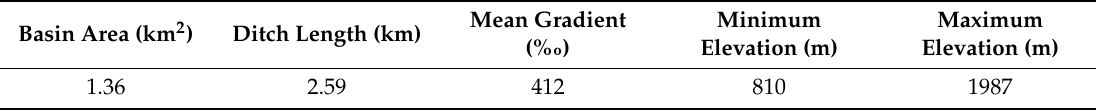
Table 1. Geomorphological parameters of Xiaogangjian gully.